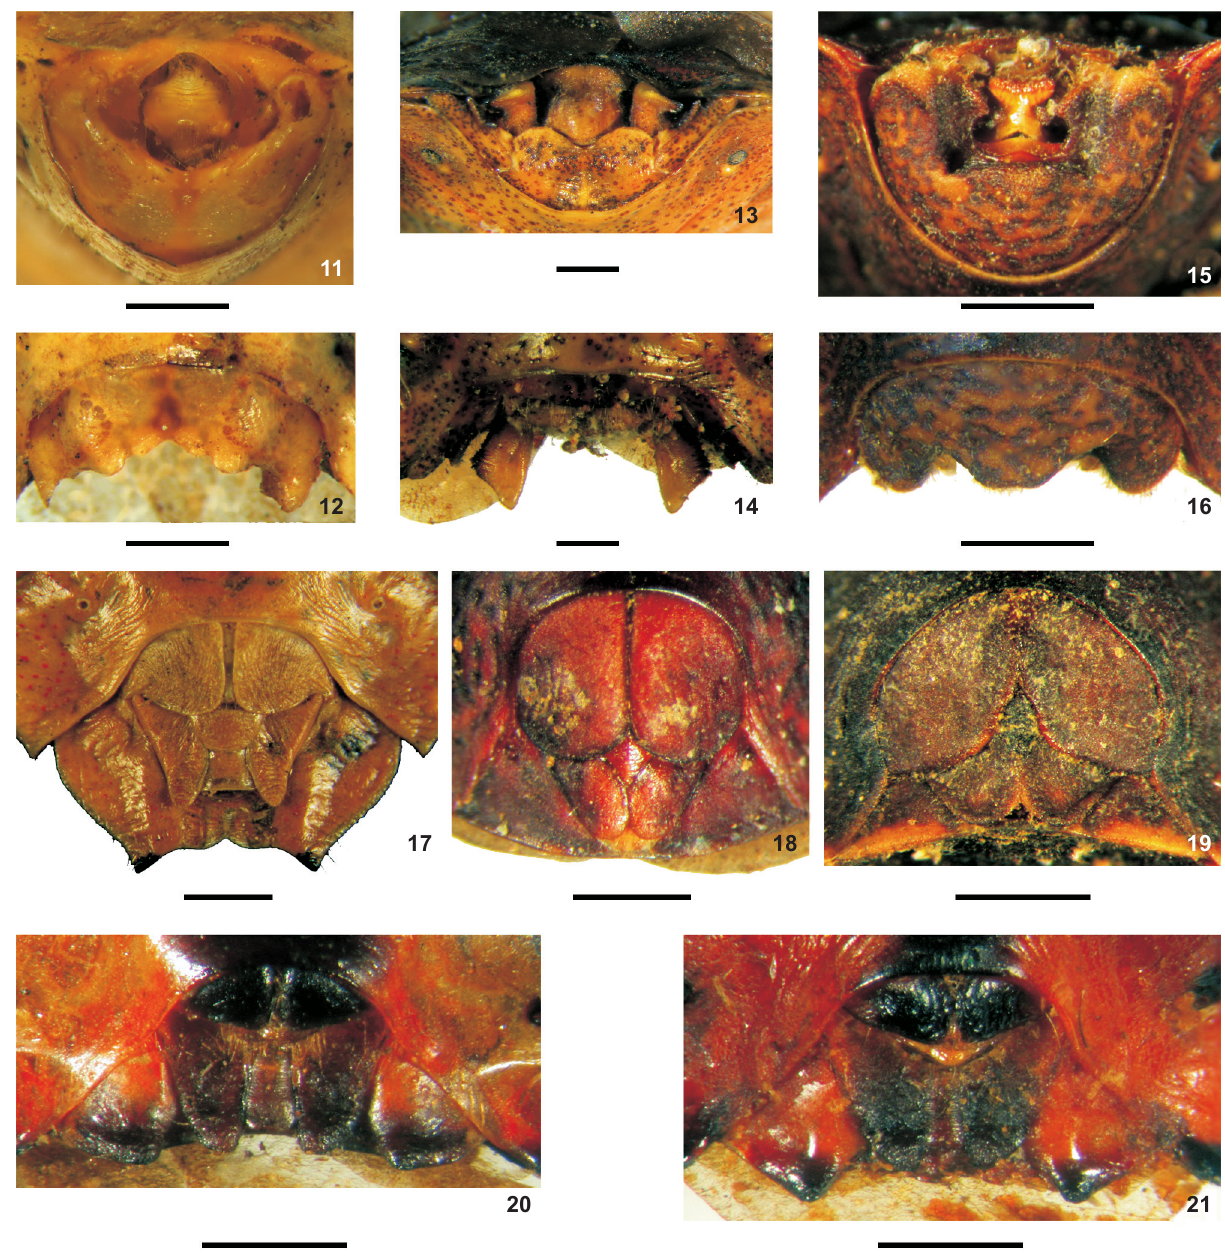
Figures 11-21. Types of Neotropical Pentatomidae of the Spinola Collection, Museo Regionale de Scienze Naturali, Turin. Genitalia: (11-12) Arvelius gladiator , male lectotype: (11) posterior view; (12) ventral view; (13-14) Cataulax macraspis , male holotype: (13) posterior view; (14) ventral view; (15-16) Schaefferella litigiosa , male lectotype: (15) posterior view; (16) ventral view; (17) Chlorocoris tau , female lectotype, ventral view; (18) Audinetella bipunctata , female lectotype, posteroventral view; (19) Ochlerus cinctus , female lectotype, posteroventral view; (20) Vulsirea ancora , female holotype, ventral view; (21) Vulsirea nigrorubra , female holotype, ventral view. Scales = 1